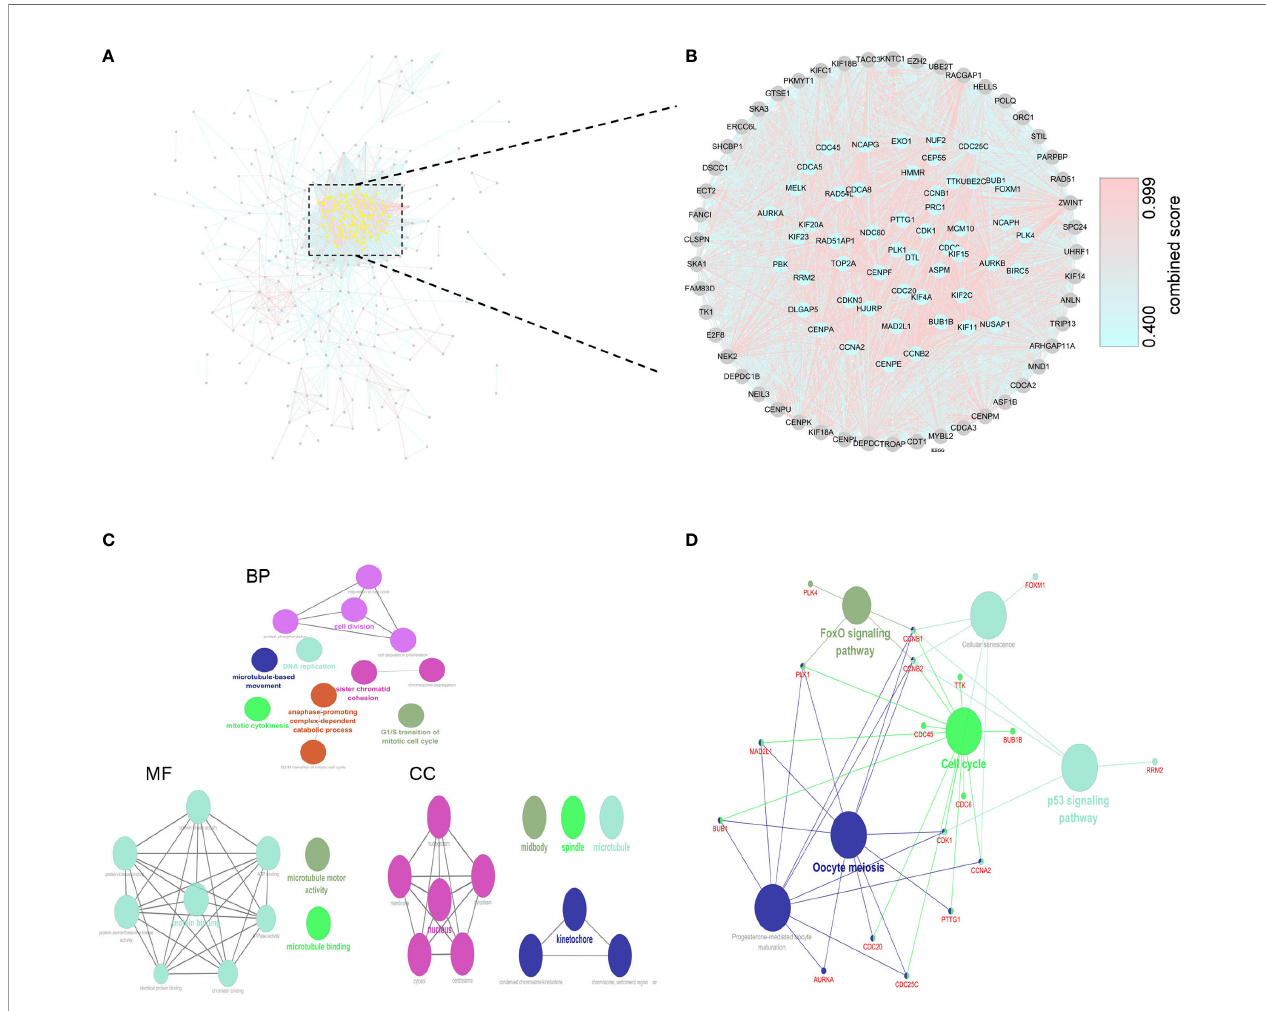
FIGURE 3 | Construction of PPI network and corresponding enrichment analysis of hub genes. (A) PPI network of 424 DEGs. (B) The crucial module identi fi ed by MCODE. The grey or yellow dots represent genes or hub genes, respectively, and the color gradients from sky blue to rose hermosa represent the combined score of two genes. (C) GO analysis of hub genes. (D) KEGG analysis of hub